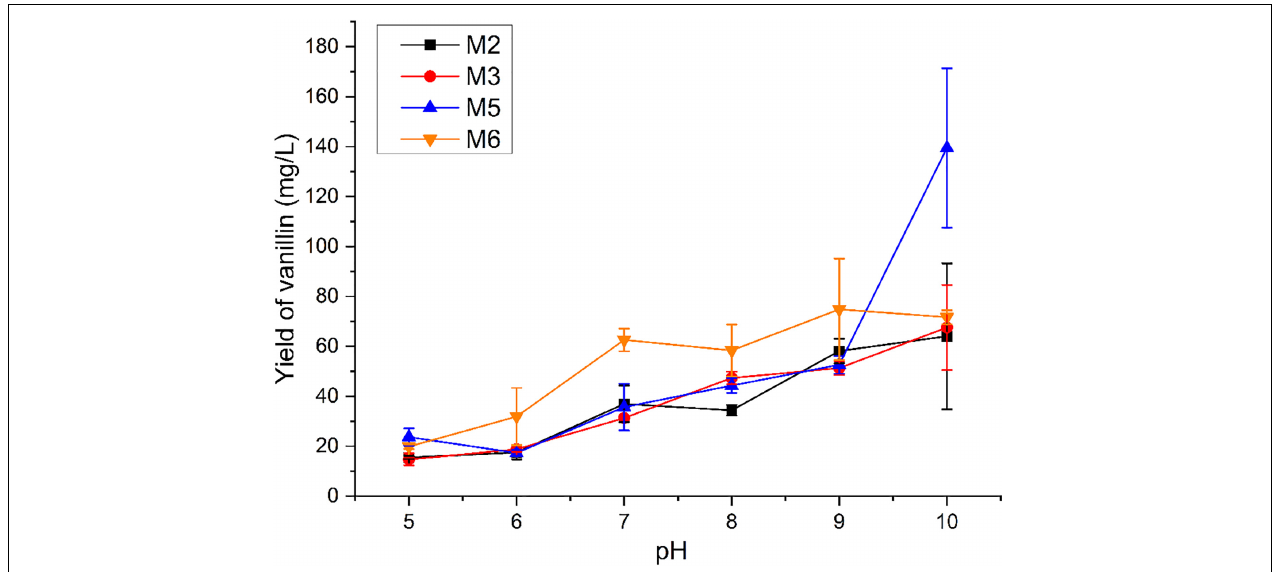
FIGURE 3 | Measurement of vanillin production catalyzed by monooxygenases using isoeugenol as the substrate under different pH